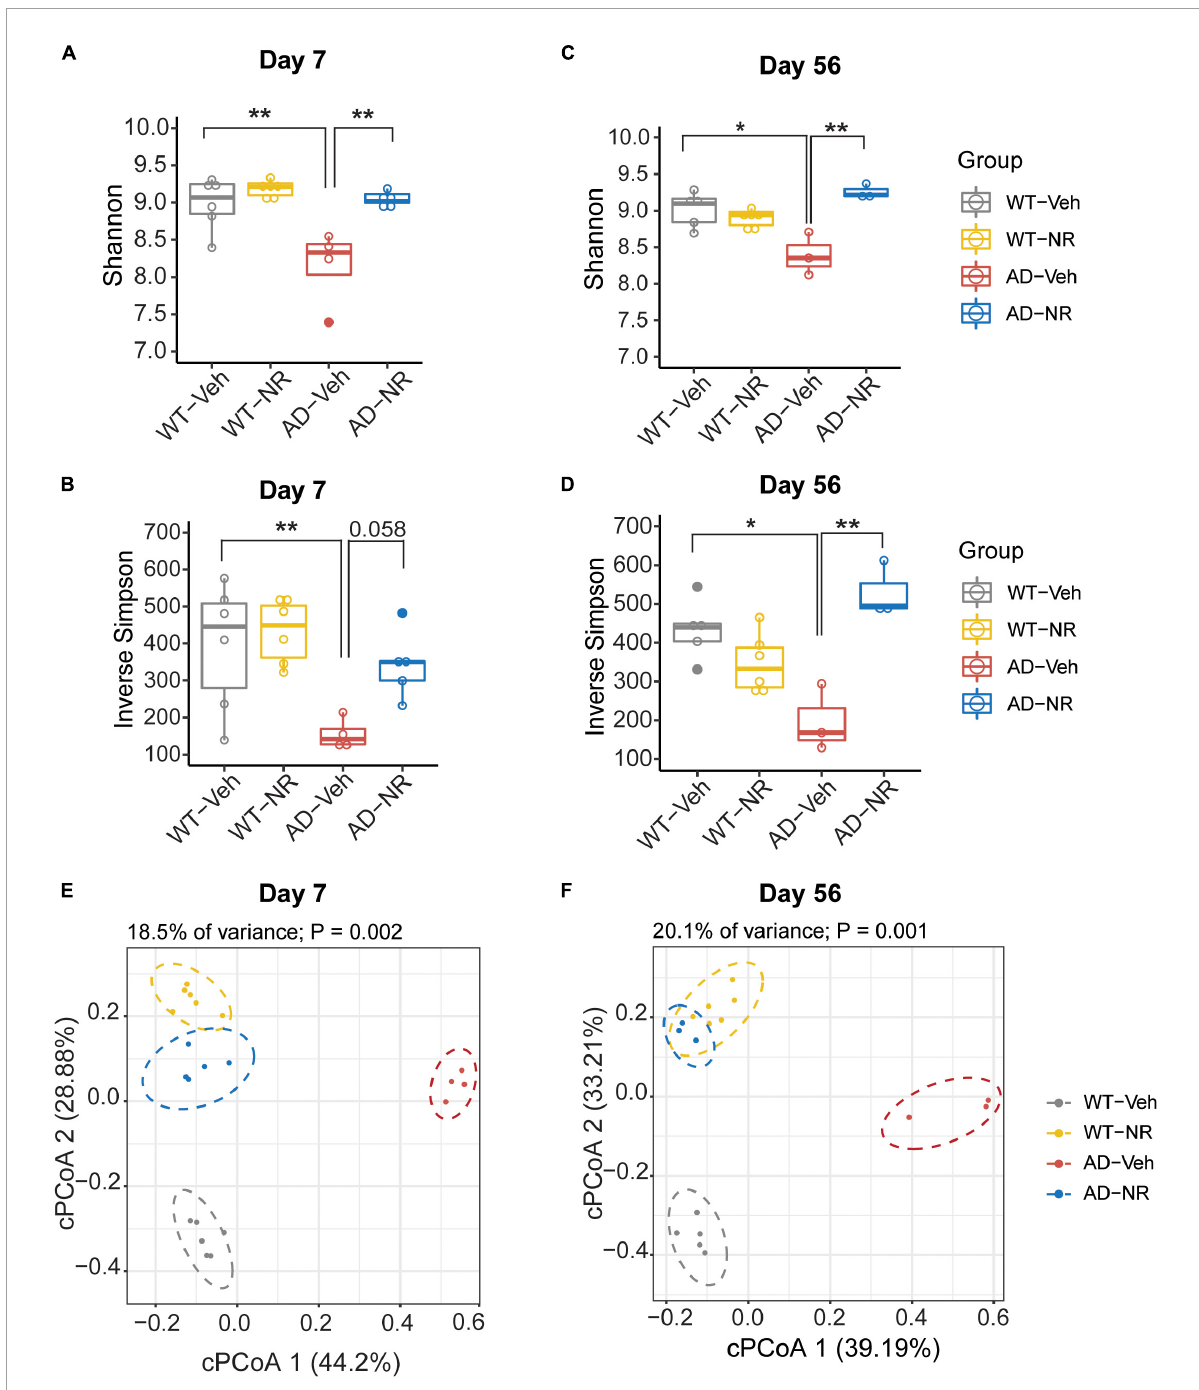
FIGURE5 Microbial diversity changed after 1 and 8 weeks of nicotinamide riboside (NR) treatment. (A–D) Alpha diversity is represented by Shannon diversity and inverse Simpson on Day 7 and Day 56, respectively. n = 3–6, * P < 0.05, ** P < 0.01, two-way analysis of variance (ANOVA) followed by Tukey’s post-hoc test. Data are shown as all samples with a boxplot. (E,F) Beta diversity is represented by constrained principal coordinate analysis (cPCoA) analysis using genotype and treatment as the constraining variables and ordinated with Jaccard dissimilarity on Day 7 (E) and Day 56 (F) , respectively. For Day 7, WT-Veh (5 males and 1 female), WT-NR (4 males and 2 females), AD-Veh (3 males and 1 female), AD-NR (3 males and 2 female), 10-month-old; For Day 56, WT-Veh (4 males and 1 female), WT-NR (4 males and 2 females), AD-Veh (2 males and 1 female), AD-NR (2 males and 1 female),